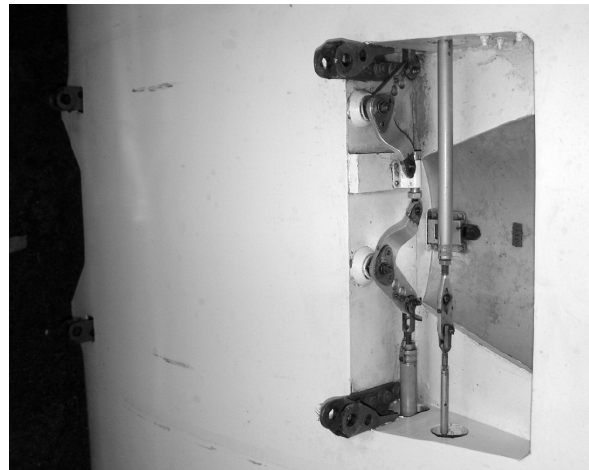
Fig 17. Four-point joints in centre